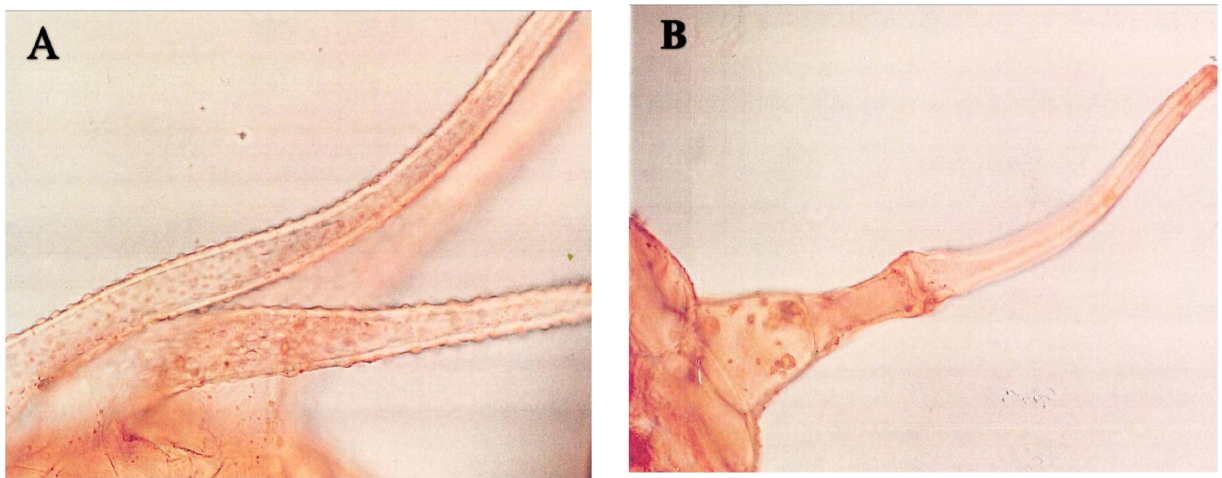
Fig. 7. Serrate bulbous hair in Heliotropium sp (A); Three cellular bulbous hair Heliotropium sp